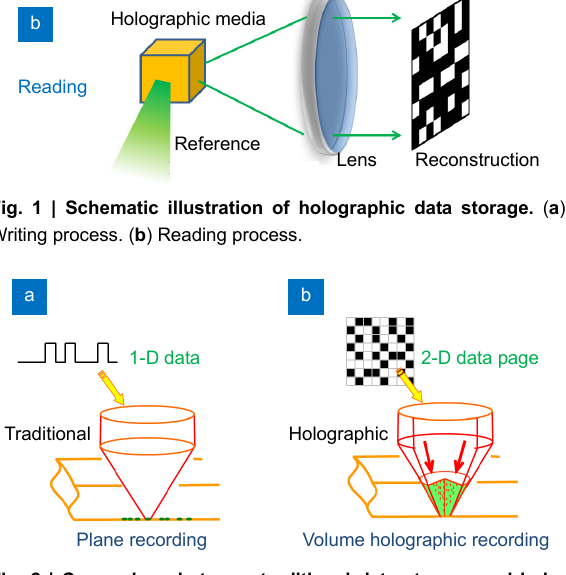
Fig. 2 | Comparison between traditional data storage and holo- graphic data